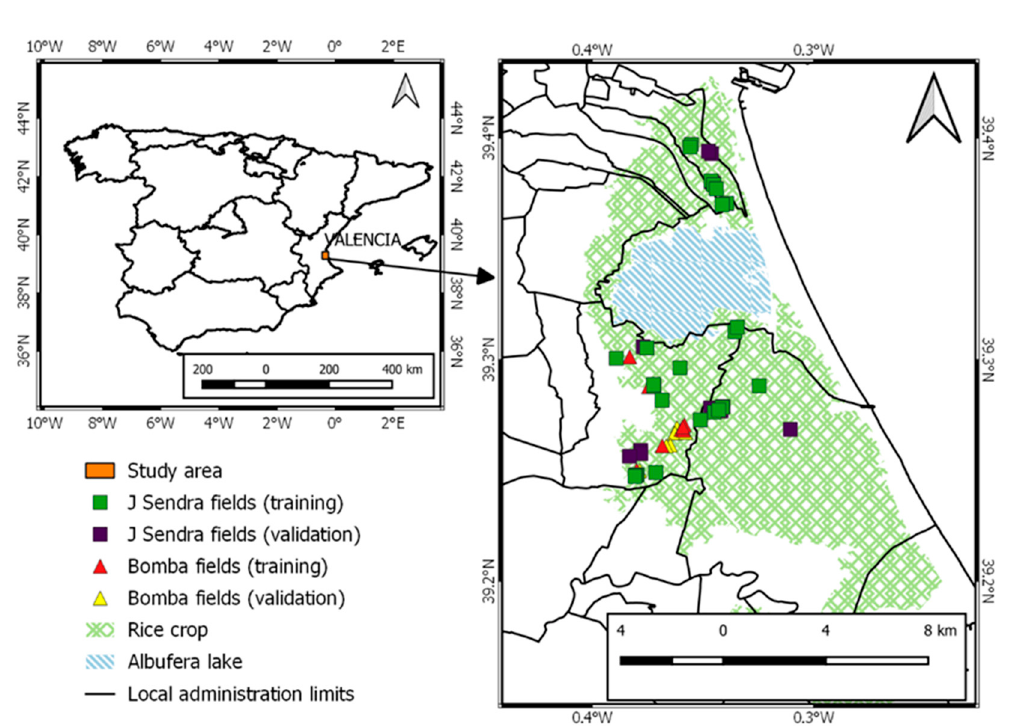
Figure 2. Location of the rice fields analyzed in this study. Table 3. Field data dissemination to build and evaluate the algorithms (the number of pixels was obtained at 10 m (20 m in parenthesis)).